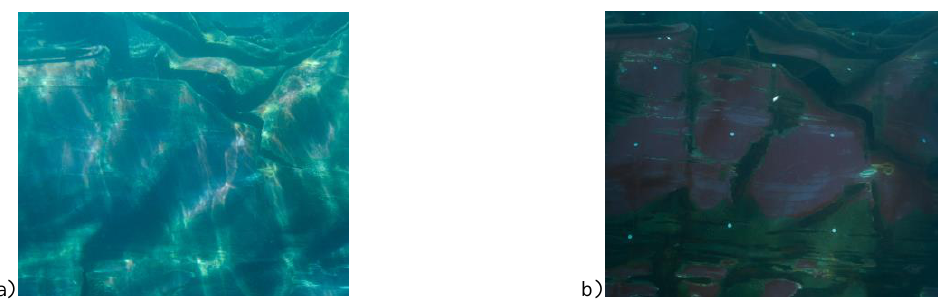
Figure 3. Effect of sunlight reflections: the two images show the same submerged area with (a) and without (b)